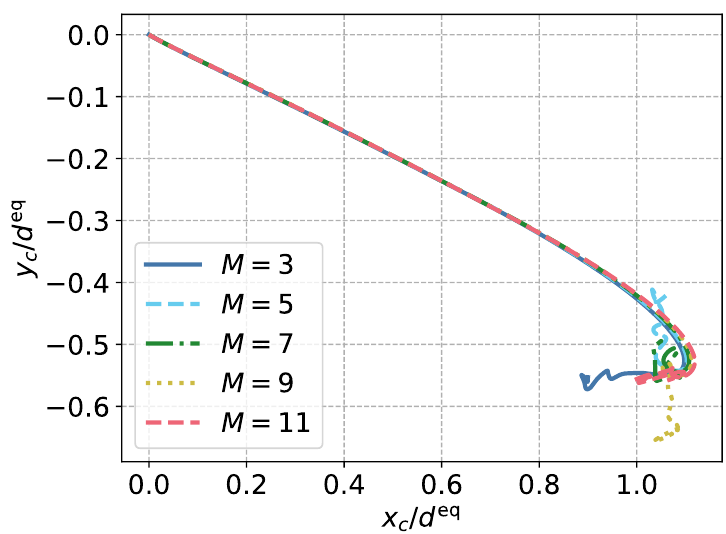
Figure 7. Coordinates of the center of mass of the particle projected, on a plane normal to the settling direction. Results printed for different grid spacings, for the particle with the longest